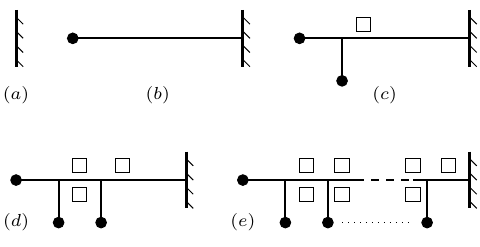
Figure 4 . Our convention for the basis of multi- (cid:28) (cid:22) (cid:28) Hilbert space on a disk. A (cid:28) (cid:22) (cid:28) in the bulk is denoted by a black dot. A place-holder for the pseudo-species is a box. (a) Abstract presentation of the disk’s boundary. We always draw the boundary on the right. (b) A single (cid:28) (cid:22) (cid:28) in the bulk; it must be attached to the boundary by an edge. (c) Adding the second (cid:28) (cid:22) (cid:28) , which introduces